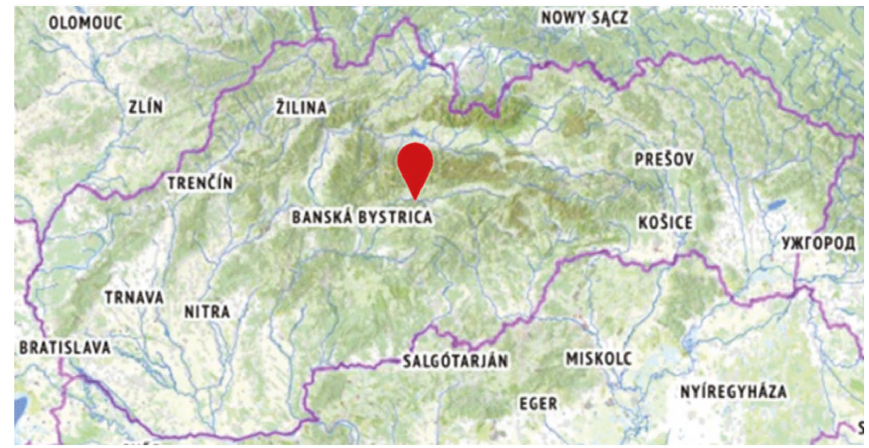
Figure 1: Location of the railway station Podbrezov´a on the map of Slovakia [19]. Table 1: Number and type of tracks at the Podbrezov ´ a railway